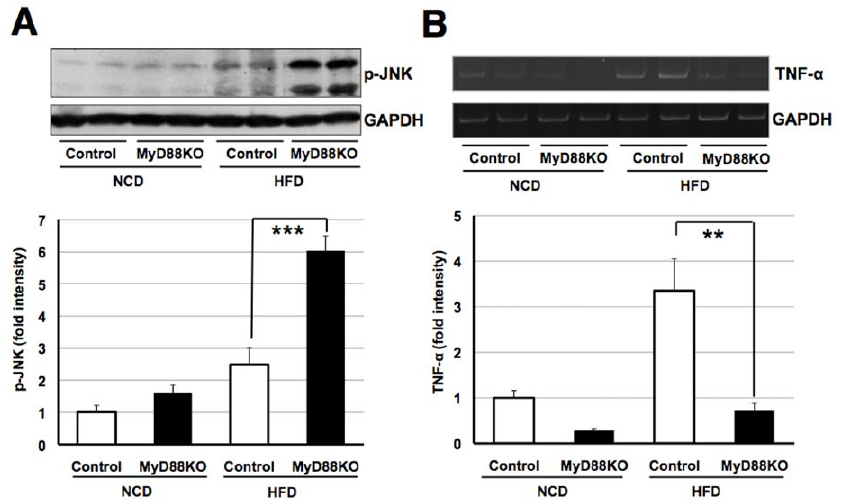
Figure 4. JNK activation without affecting TNF- a levels in MyD88-deficient mice fed the HFD. ( A ) Western blot analysis of p-JNK in liver samples at the age of 18 weeks. Each genotype of mice was fed the NCD (n=7) or HFD (n=6–8). *** p , 0.001 ( B ) mRNA level of TNF- a was measured in liver samples at the age of 18 weeks. (n=6–8) ** p , 0.01.